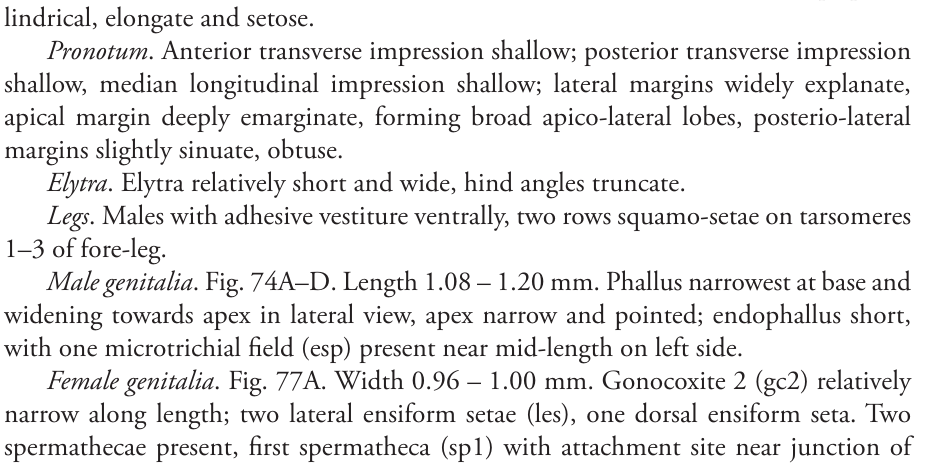
Head . Mandibles curved at apex; labrum long, bilobed, setose towards apex, setae visible when viewed laterally; mentum with tooth; eyes moderately convex; palpi cy- lindrical, elongate and